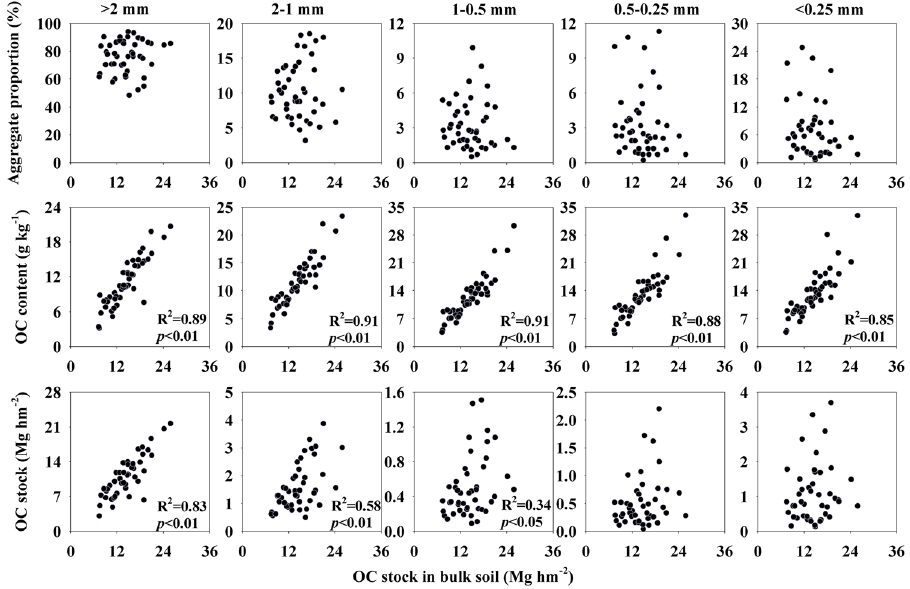
Figure 5. Correlations between the proportion, OC content and stock associated with aggregates and OC stocks in bulk soils (0–30